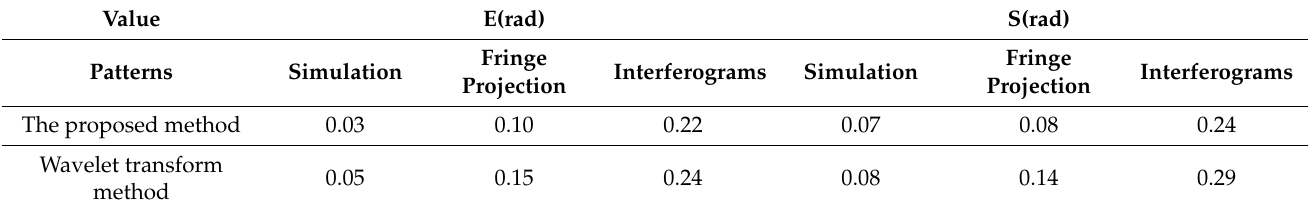
Table 1. E and S of the proposed method and wavelet transform method.